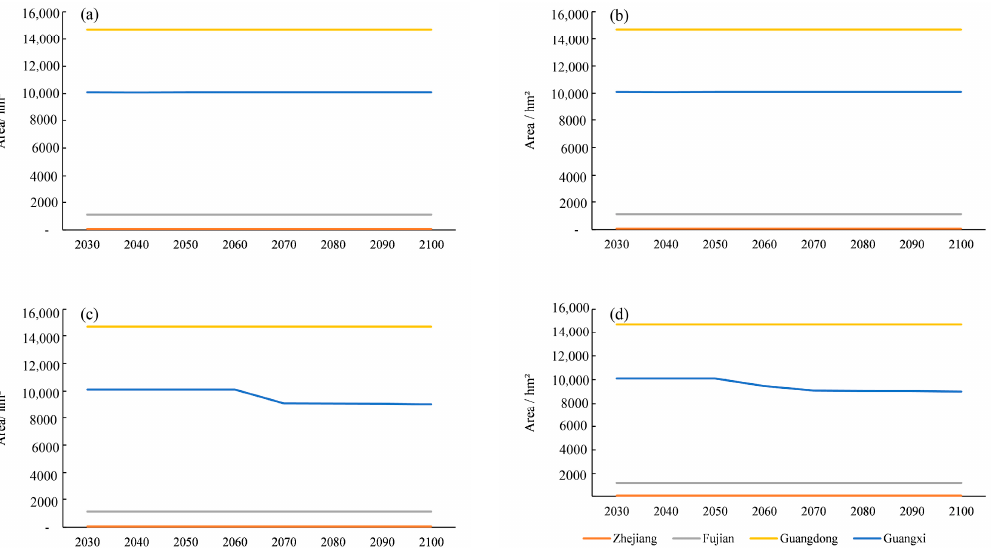
Figure 5. Mangrove changes by regions. The color of the line indicates different regions (Ze jiang, Fujian, Guangdong, Guangxi). ( a ) SSP1-2.6, ( b ) SSP2-4.5, ( c ) SSP3-7.0, ( d ) SSP4-8.5.